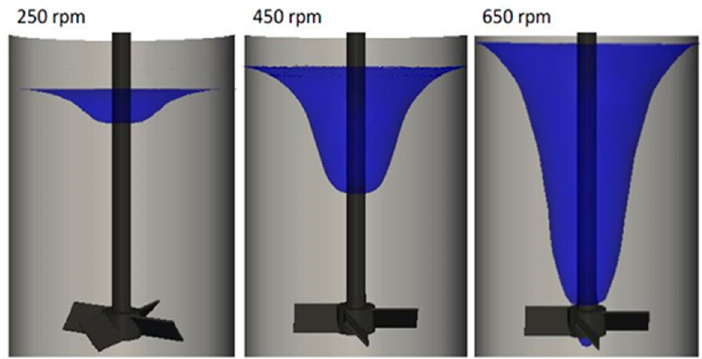
Figure 5. Predicted shapes of the large-scale vortex at different rotation speeds.